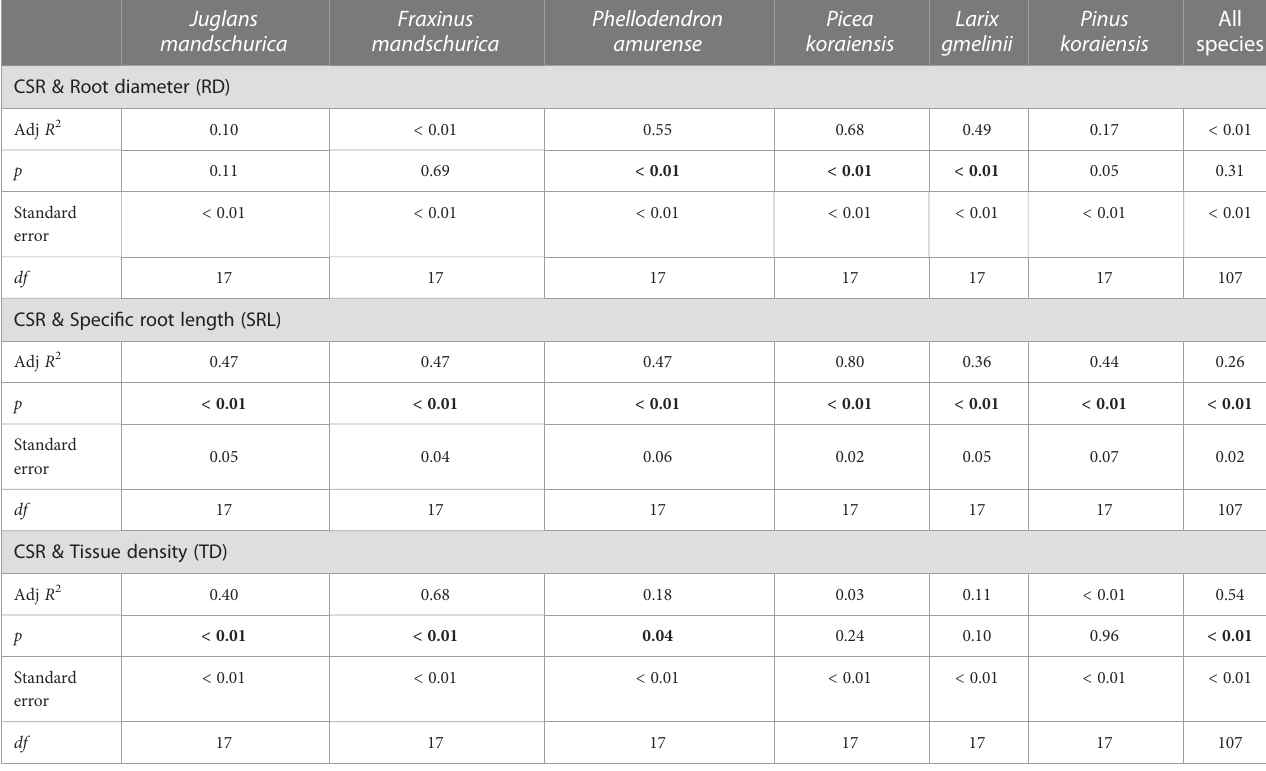
TABLE 6 Group-wise regression of the ratio of unilateral cortex thickness to stele radius (CSR) and root diameter, speci fi c root length and tissue density in three angiosperms and three gymnosperms tree